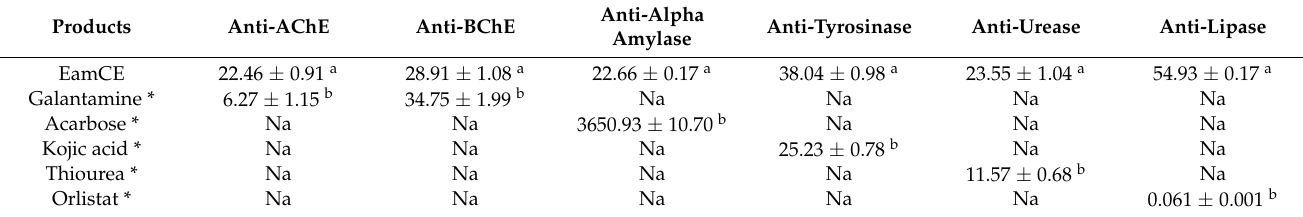
regression analysis and expressed as mean ± SD ( n = 3). The values with different superscripts ( a , b , c , d , e ) in the same columns are significantly different ( p < 0.05). Table 4. Anti-enzymatic results (IC 50 µ